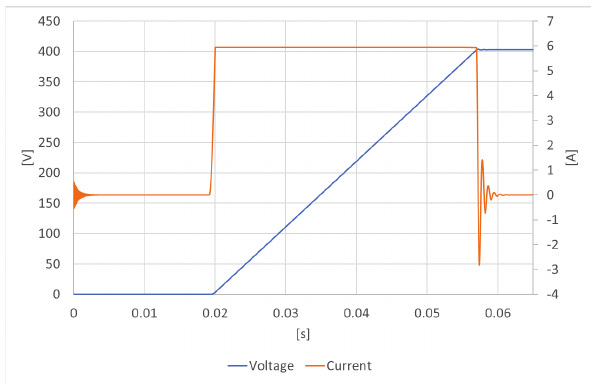
Fig. 9. Linear mode method DC-Link capacitance